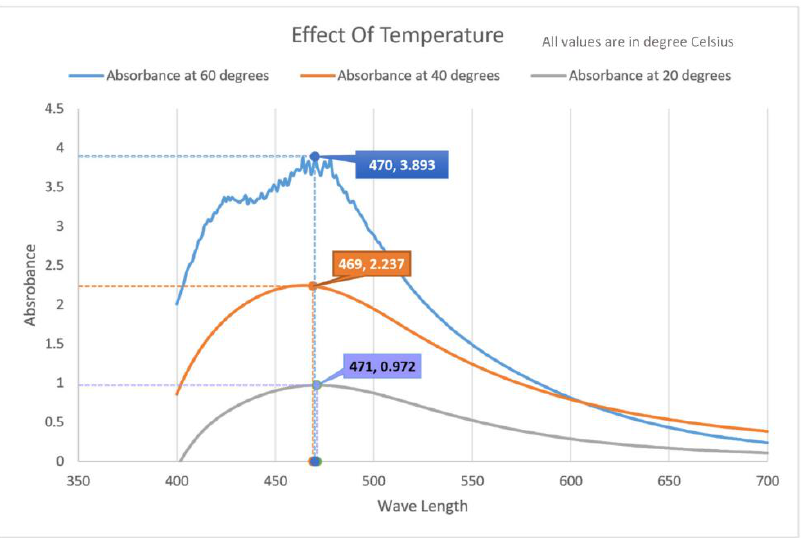
Figure 3. Effect of temperature on the size and shape of nanoparticles. At 60 °C, the peak absorbance was recorded highest at 3.893 with an SPR of 470 nm. At 40 °C, the SPR was observed at 469 nm, was recorded highest at 3.893 with an SPR of 470 nm. At 40 ◦ C, the SPR was observed at 469 nm, and the absorbance peaked at 2.237. At 20 °C, the peak was observed at 471 nm, and the highest and the absorbance peaked at 2.237. At 20 ◦ C, the peak was observed at 471 nm, and the highest absorbance was 0.972. absorbance was